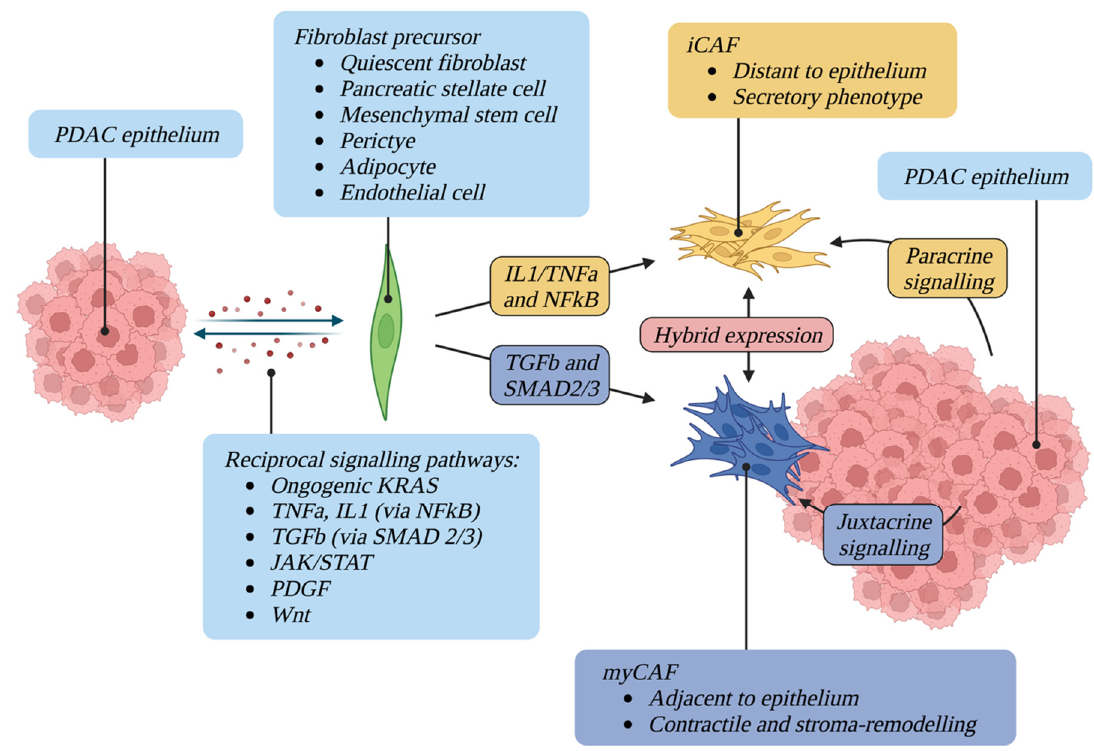
Figure 1. CAF activating factors and plasticity. A complex network of reciprocal signalling pathways maintains the activation of CAFs, which can originate from a multitude of different precursors. Once differentiated, CAFs display different phenotypes and spatial relationships with tumour epithelium. CAFs are phenotypically plastic and can convert between states.